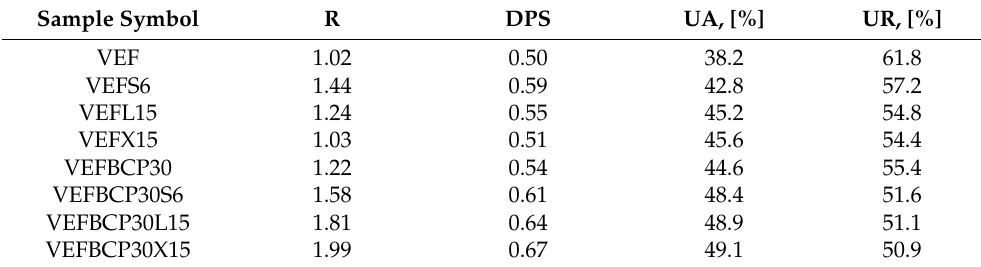
Table 4. The results of the analysis of Fourier transform infrared spectroscopy (FTIR) spectra fragments in the range of bands of carbonyl groups.